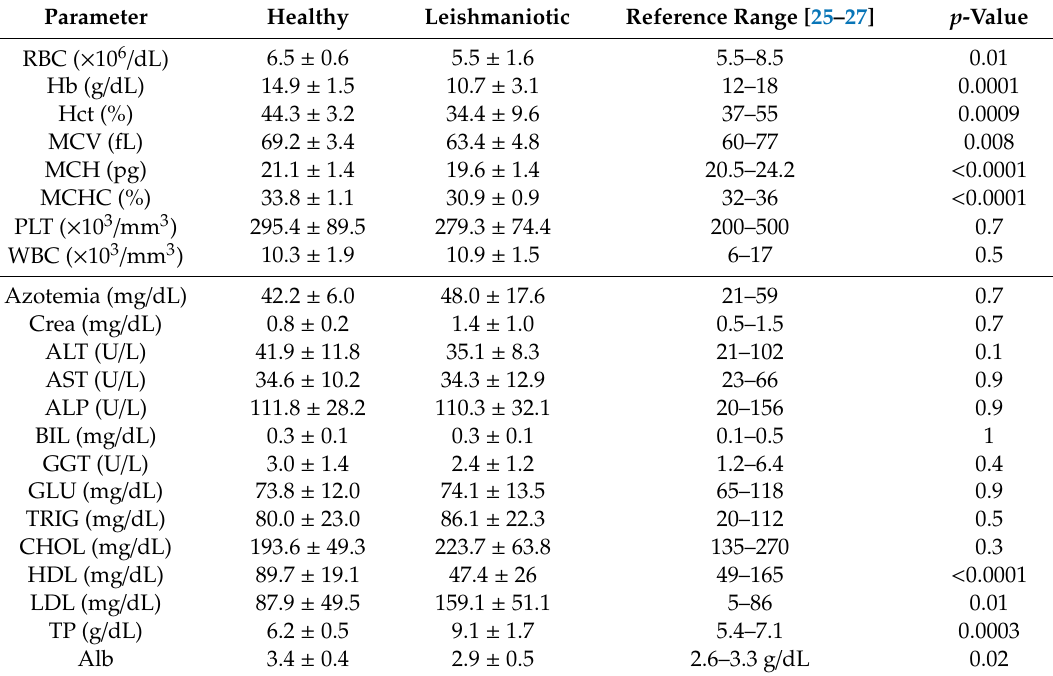
Table 1. Hematological and biochemical parameters in healthy and a ff ected